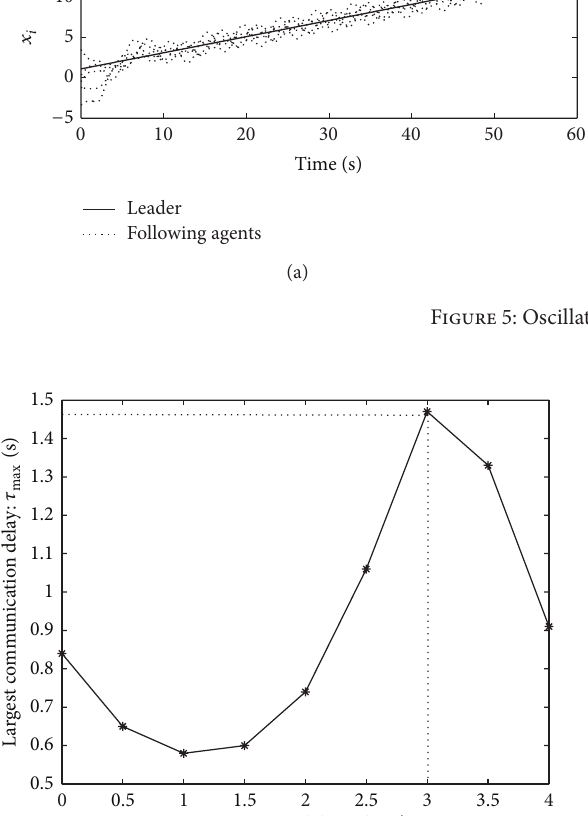
Figure 6: Bound of communication delay with different 𝜁